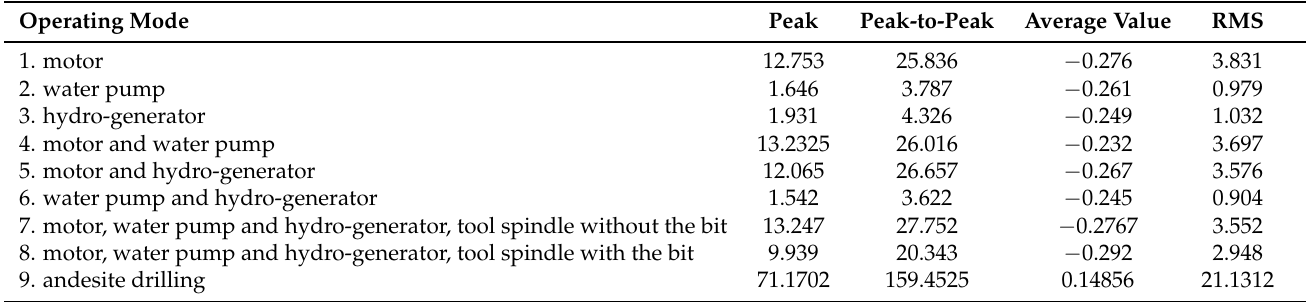
Figure 8. Histogram of probability distribution of measured signals (( a ) normal Gaussian distribution, ( b ) non-Gaussian distribution). Table 1. Statistical characteristics of operating